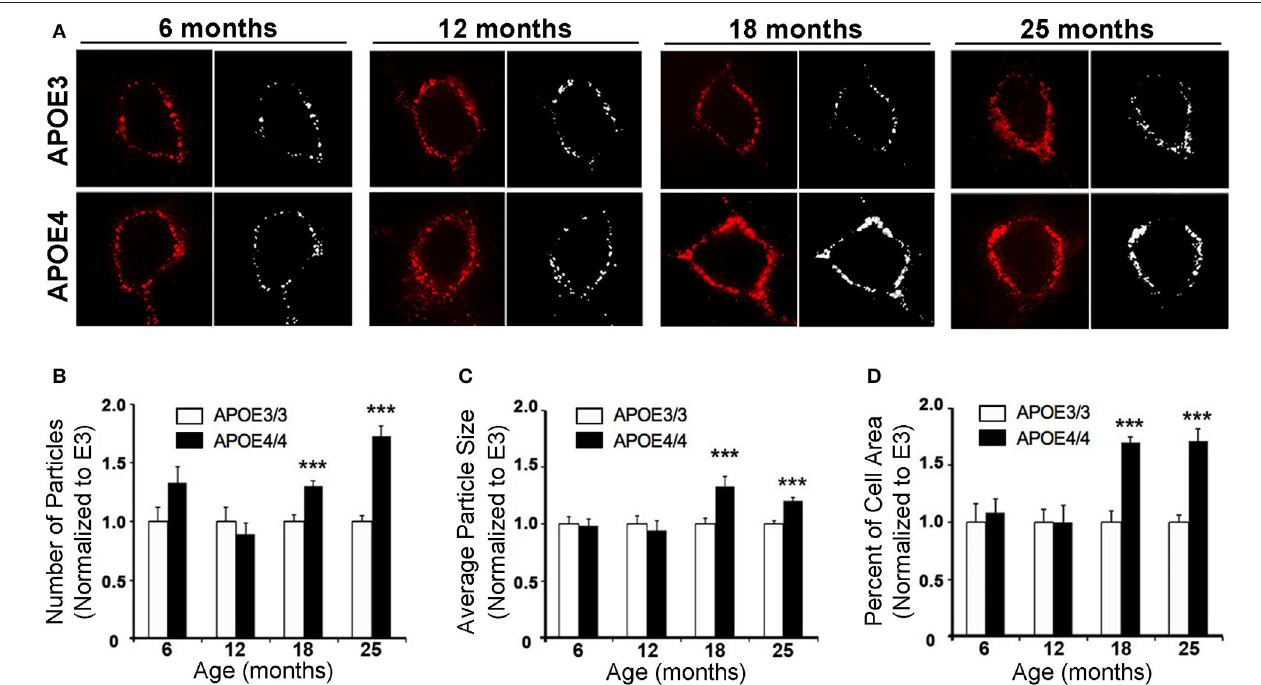
FIGURE 5 | The number, size and area fraction of Rab5a-immunoreactive early endosomes are increased in the cingulate cortex of APOE4/4 vs. APOE3/3 mice with age. Rab5a-immunoreactive early endosomes were quantified in the cingulate cortex of 6, 12, 18, and 25 month-old APOE3/3 and APOE4/4 mice. (A) Representative images showing Rab5a immunolabeling (red). Black and white images were generated in ImageJ and used for quantification. (B–D) Quantification of average Rab5a-positive early endosome number (B) , size (C) , and area fraction (D) in APOE4/4 vs. APOE3/3 mice. (*** p < 0.001; findings are normalized to the mean APOE3/3 value at each age in order to compare between age